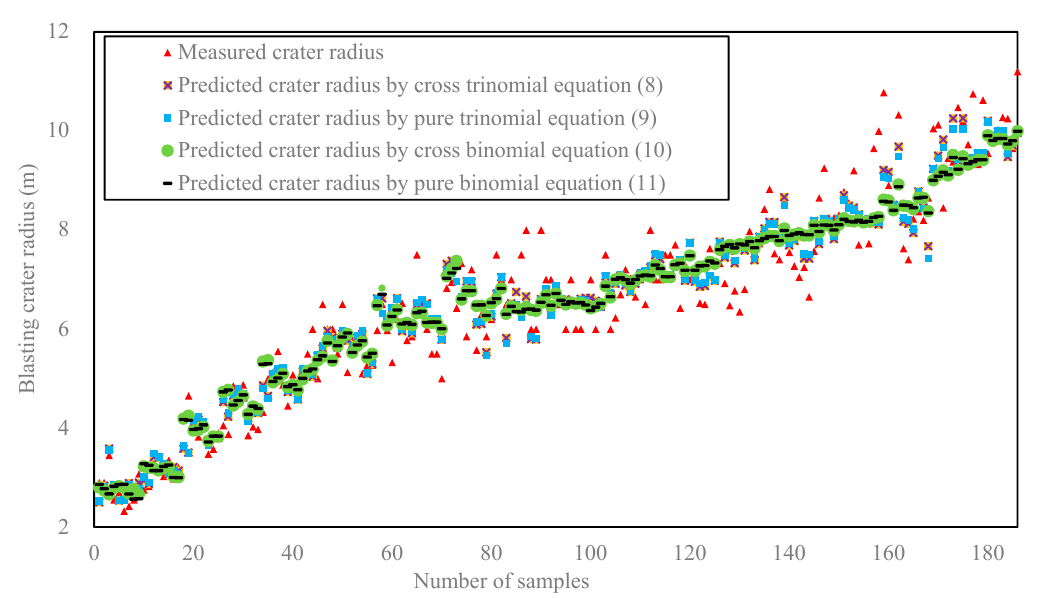
Figure 8. Scatter diagram of measured and predicted blasting crater radii.